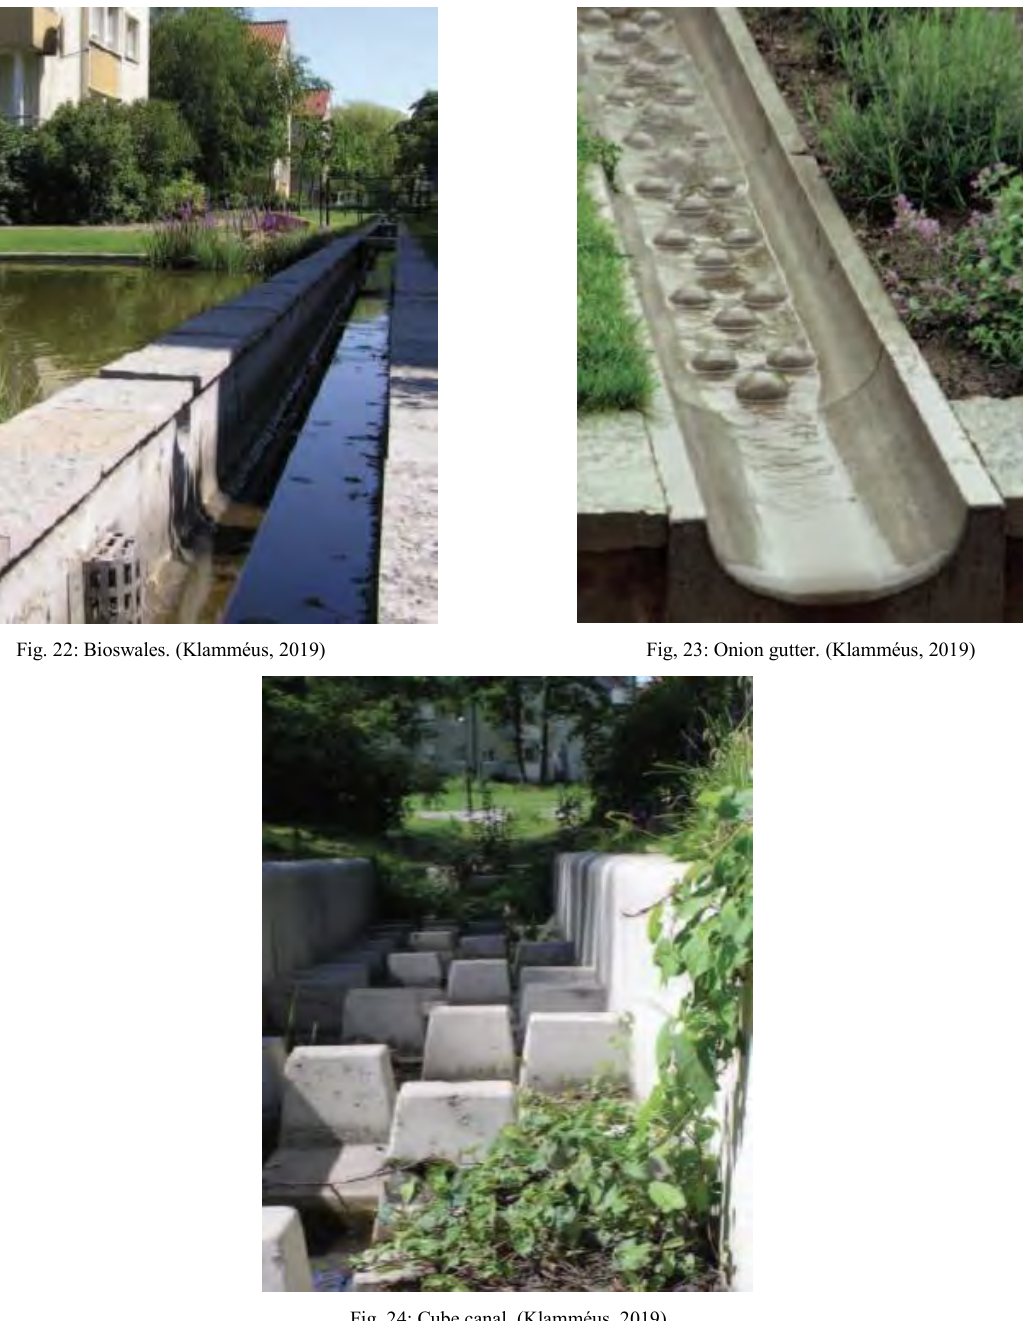
Fig. 24: Cube canal. (Klamméus,